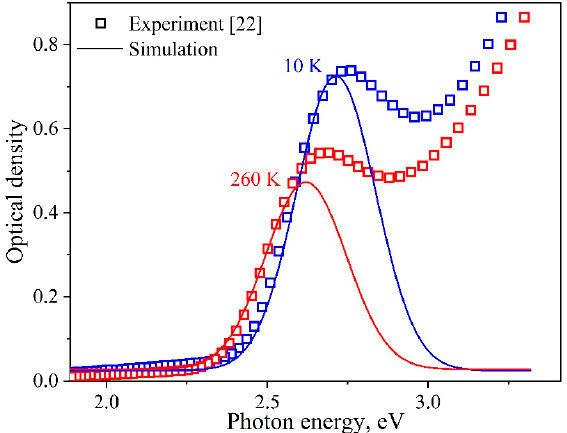
Figure 7. Experimental optical absorption spectra [22] (symbols) and simulation of the first exciton absorption band (solid lines) for QD-1 at specified temperatures.